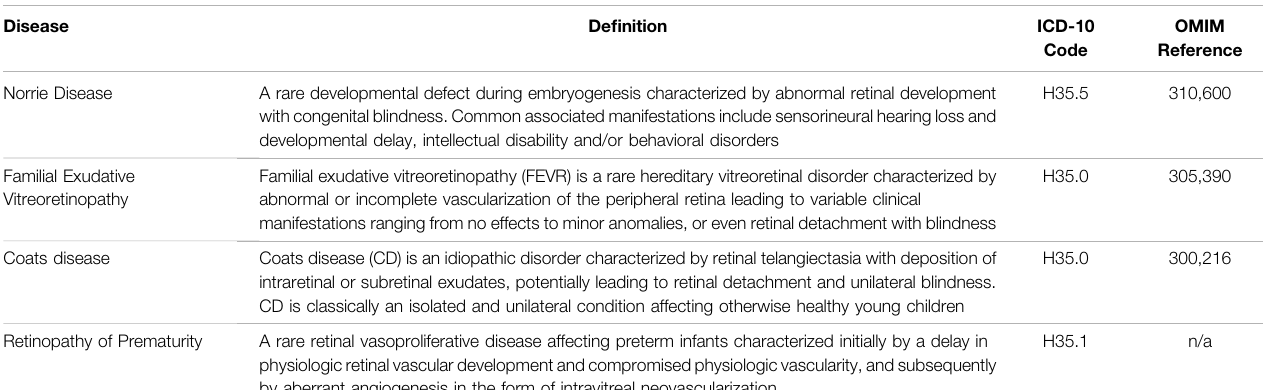
TABLE 2 | De fi nitions of the key conditions that can arise as a result of an NDP mutation.